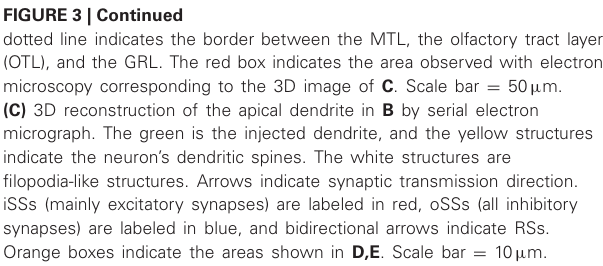
dendritic conduction of excitatory odor cues. (B) A simplified model of the AOB intrabulbar circuit. MT cells receive chemical information from vomeronasal receptor neurons (VRN) through several glomeruli and then send the information to the medial amygdala (MeA). PG cells in the AOB are not as numerous as in the MOB. MT cells in the AOB form RSs with Gr cells on primary dendrites. RSs in the AOB act as gate keeper before relaying the chemical cue to cell somas. Black arrow indicates the dendritic conduction of excitatory chemical signals, and dotted line indicates the attenuation of